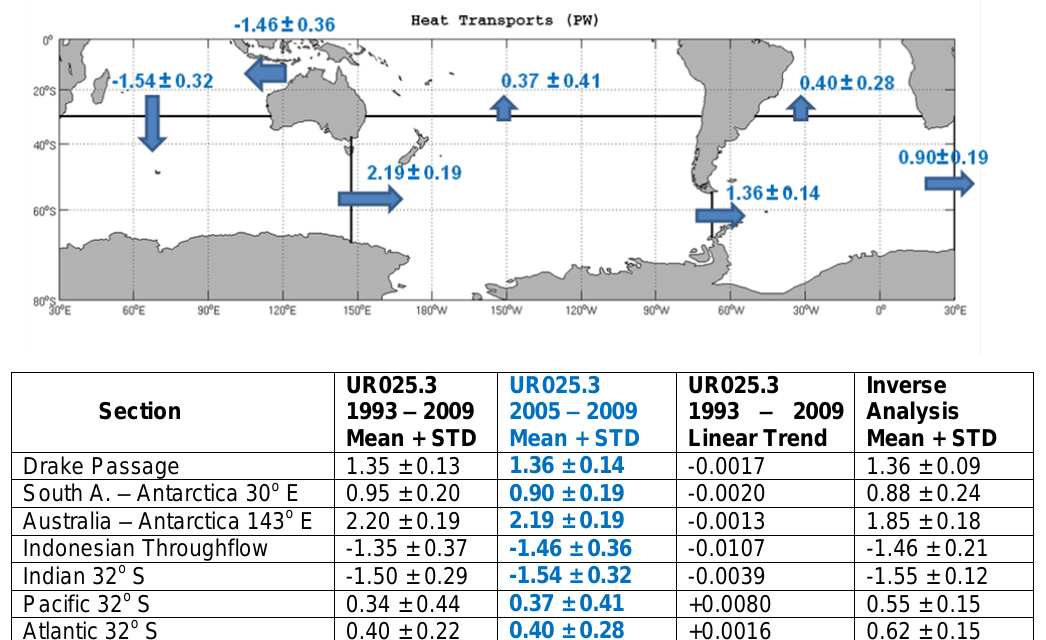
Fig. 5. Heat transports and their annual standard deviations, in PW, through major sections in the Southern Hemisphere in UR025.3 over the periods 1993–2009 and through 2005–2009, in comparison to estimates from the inverse model results of Lumpkin and Speer (2007). The trends in heat transport are in PW/year.